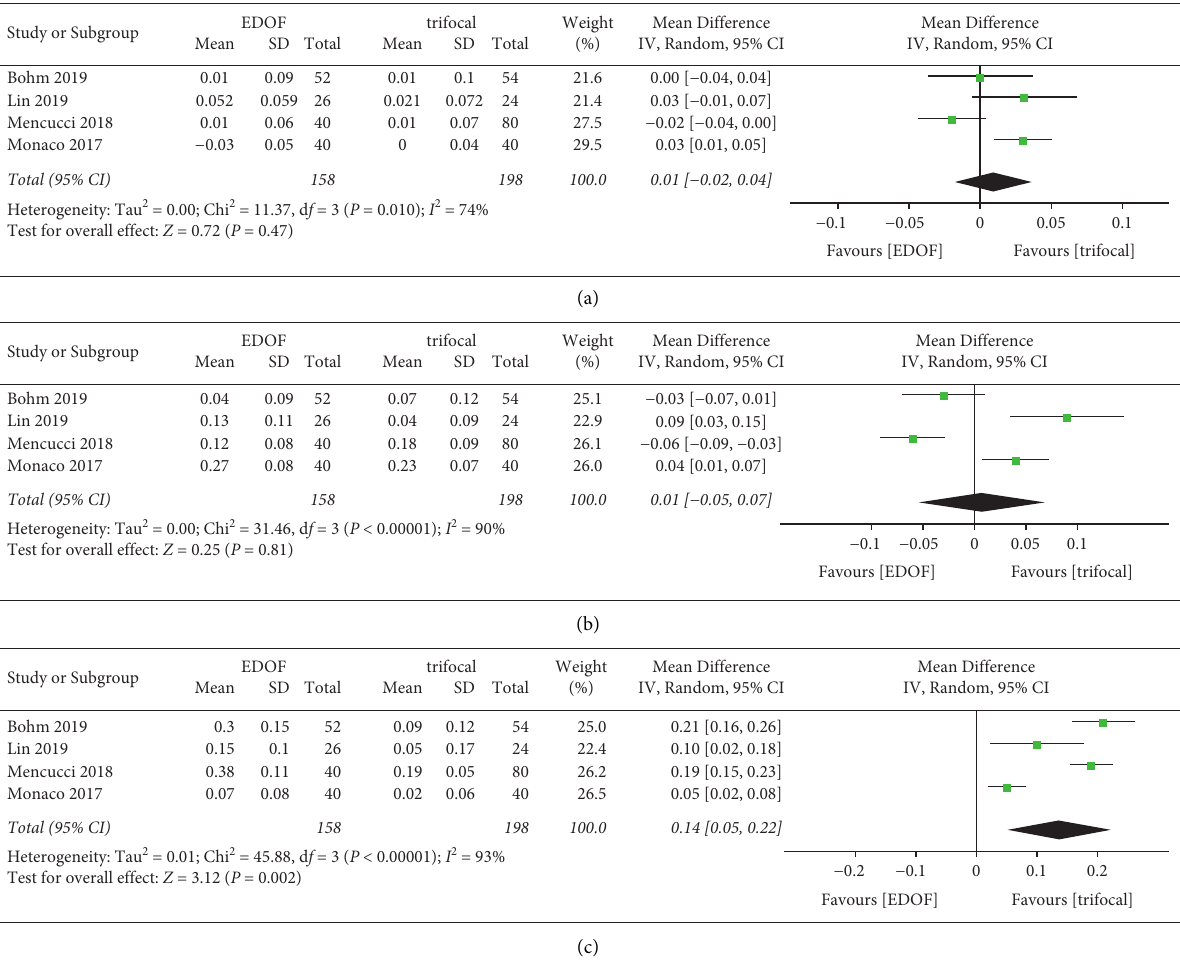
Figure 4: Forest plot of monocular uncorrected visual acuity. (a) Uncorrected distance visual acuity; (b) uncorrected intermediate visual acuity; and (c) uncorrected near visual acuity. EDOF, extended depth-of-focus; SD, standard deviation; CI, confidence interval; IV, inverse